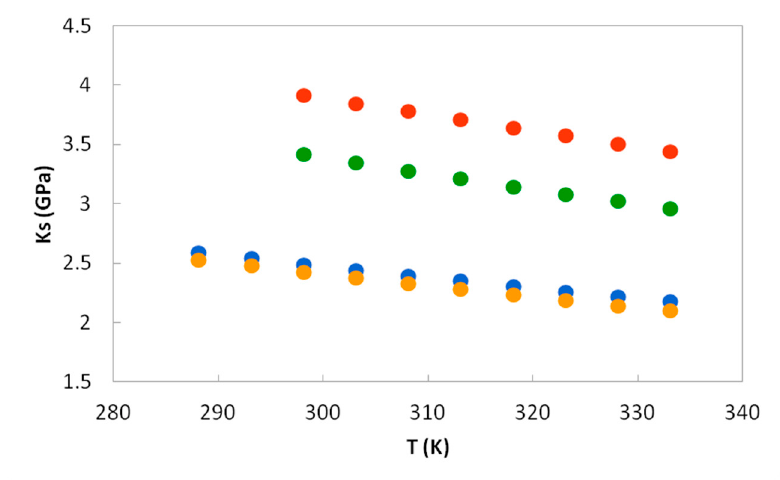
Figure 3. Adiabatic bulk modulus versus the temperature at 0.1 MPa, for dried ( ● ) and saturated ( ● ) [C 2 C 2 C 1 N][OTf]and dried ( ● ) and saturated ( ● ) [C 2 C 2 C 1 N][MeSO 3 ] ILs.